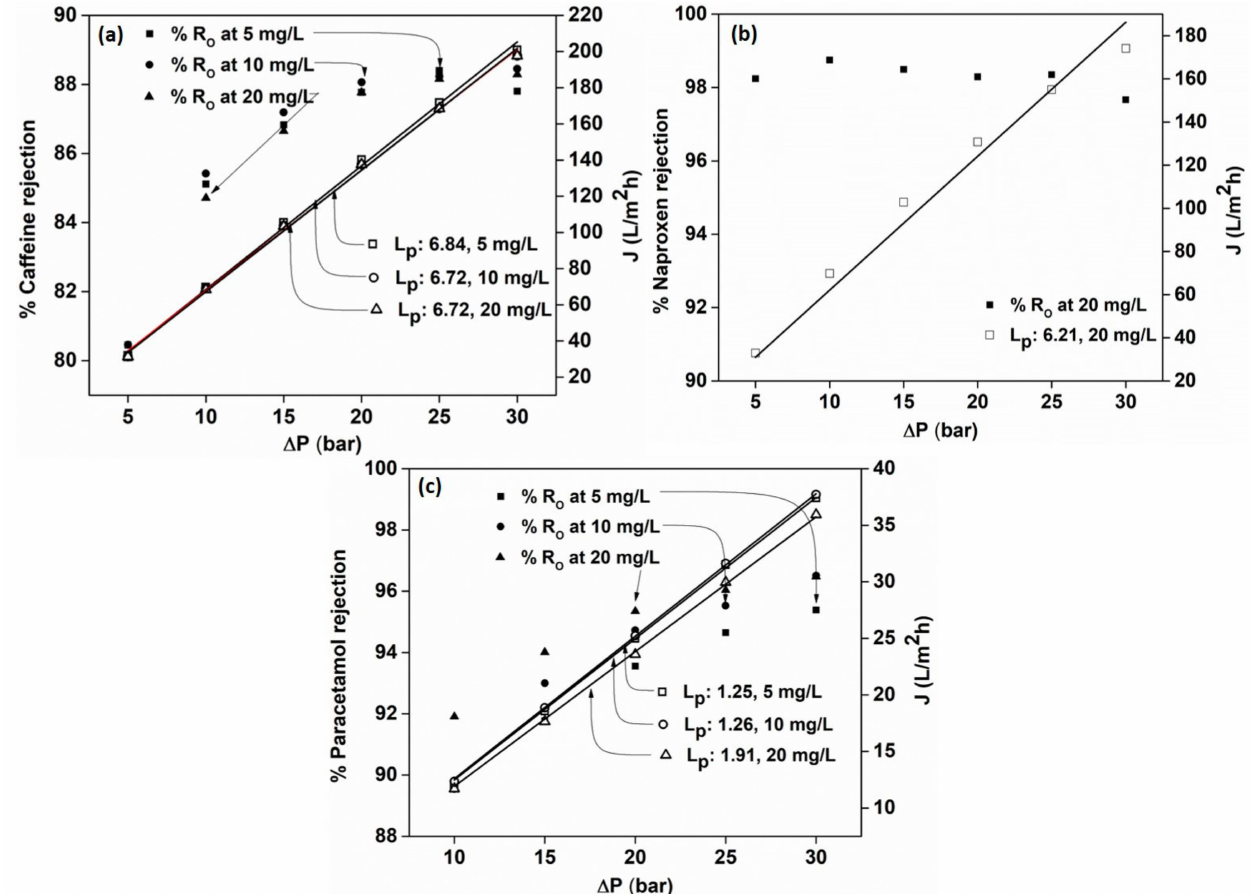
Figure 5. Effect of feed concentration on rejection efficiency of ( a ) caffeine, ( b ) naproxen and ( c )